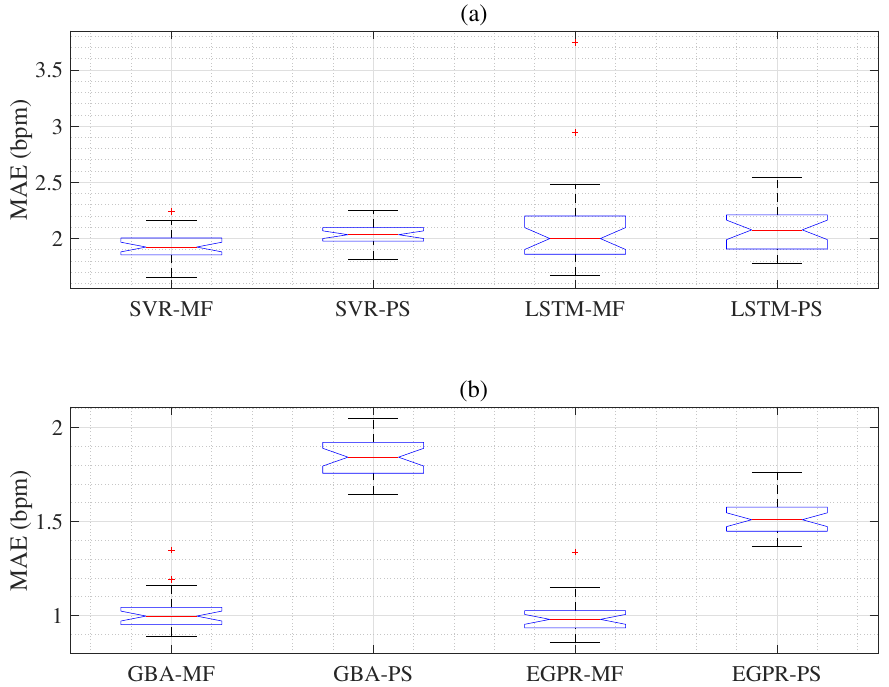
Figure 6. Top panel ( a ) denotes the MAE and SD compared to the reference RR method obtained from the PPG-based SVR-MF, PPG-based SVR-PS, PPG-based LSTM-MF, and PPG-based LSTM-PS models. Bottom panel ( b ) shows the MAE and SD compared to the reference RR method obtained from the PPG-based GBA-MF, PPG-based GBA-PS, PPG-based EGPR-MF, and PPG-based